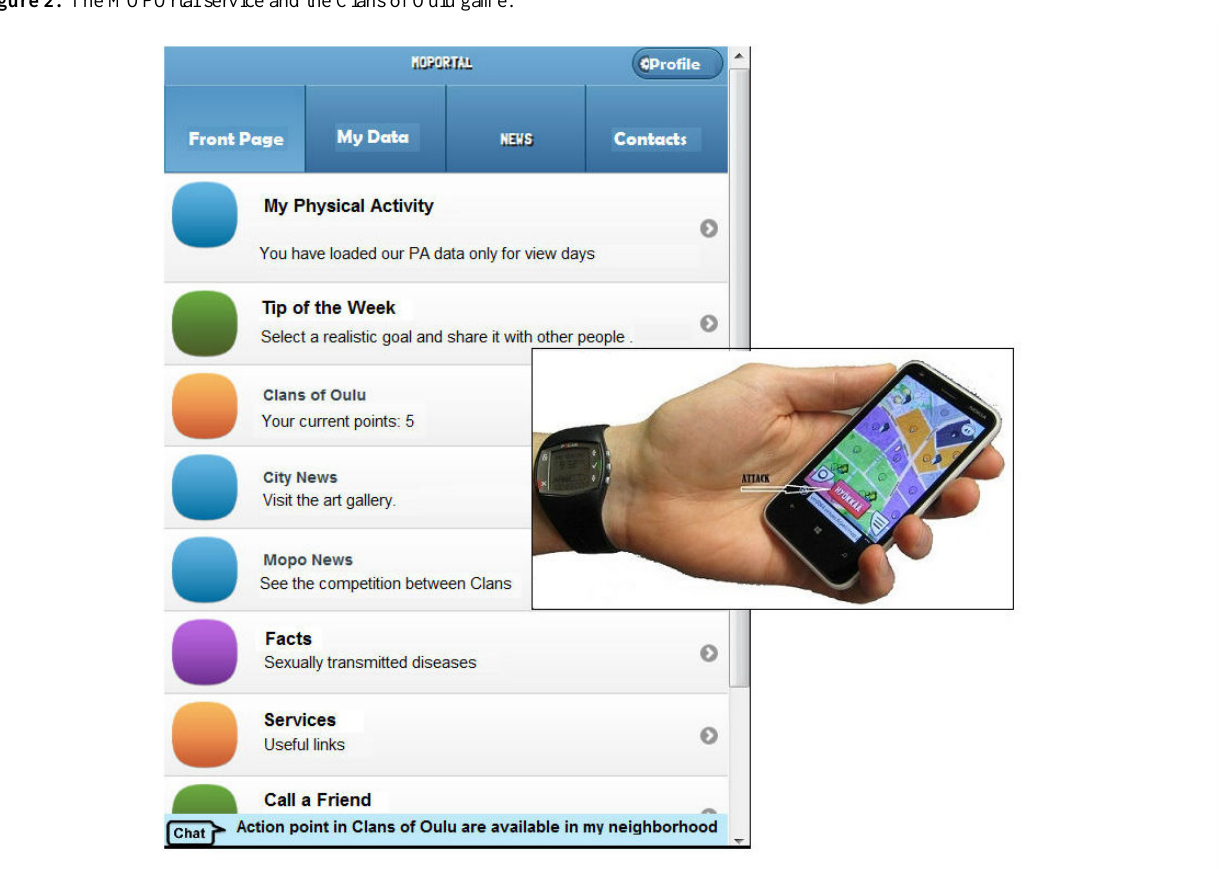
Figure 2. The MOPOrtal service and the Clans of Oulu